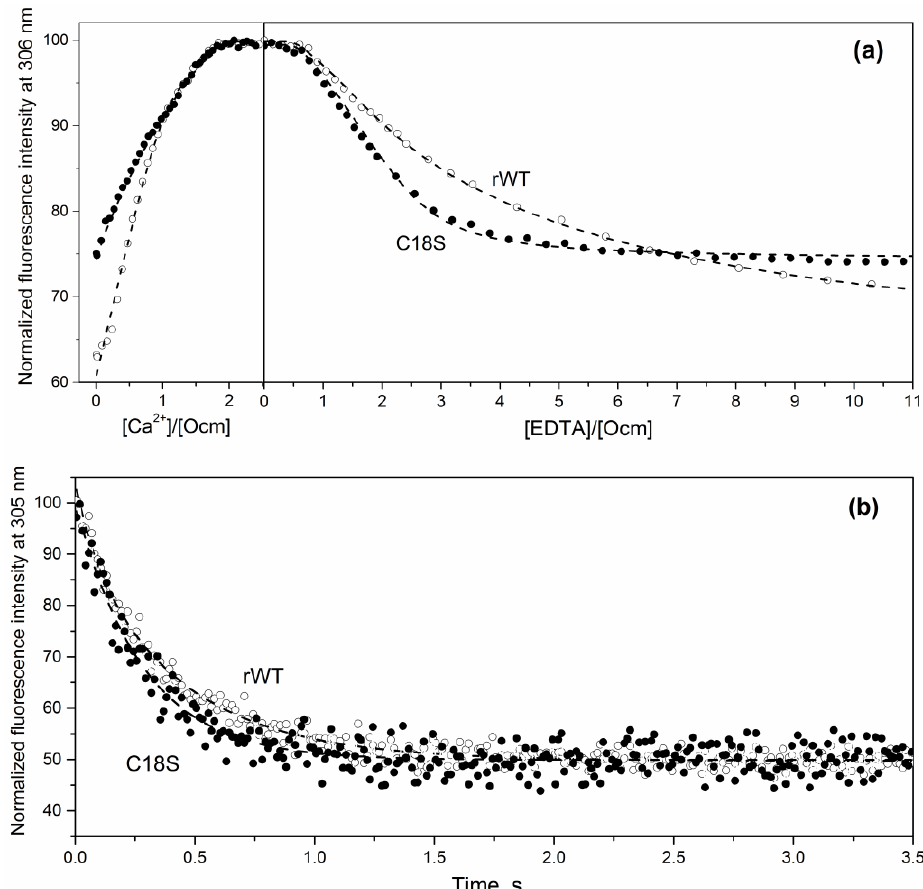
Figure 4. Fluorimetric Ca 2+ and EDTA titration of rWT/C18S Ocm ( a ) and time course of EGTA-induced Ca 2+ removal from Ocm monitored by fluorescence stopped-flow technique ( b ) at 20 °C. Buffer conditions: 10 mM HEPES-KOH, pH 8.2. Protein concentration was 5–23 µM. Excitation wavelength was 275 nm. The dashed curves are theoretical fits computed according to the sequential metal-binding scheme [IV] (see Tables 4 and 5). ( a ) The dependence of Ocm fluorescence intensity at 306 nm on total concentration of Ca 2+ /EDTA during saturation of apo-Ocm with Ca 2+ , followed by EGTA-induced Ca 2+ removal. ( b ) Ca 2+ to protein molar was 2:1; the Ca 2+ removal was initiated via addition of 1 mM EGTA.